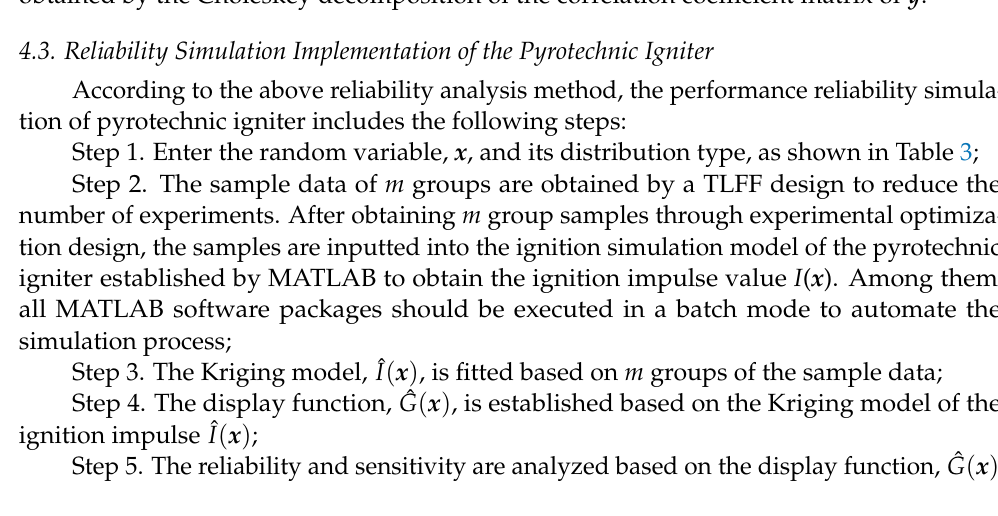
Table 3. Key design parameters for the pyrotechnic igniter. Symbol Mean